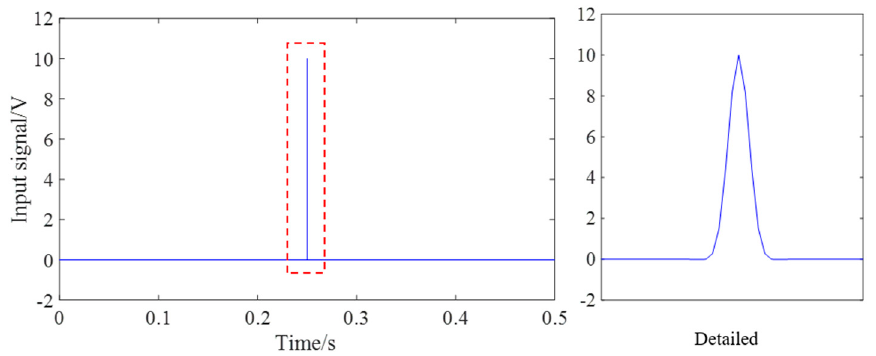
Figure 16. The input signal.